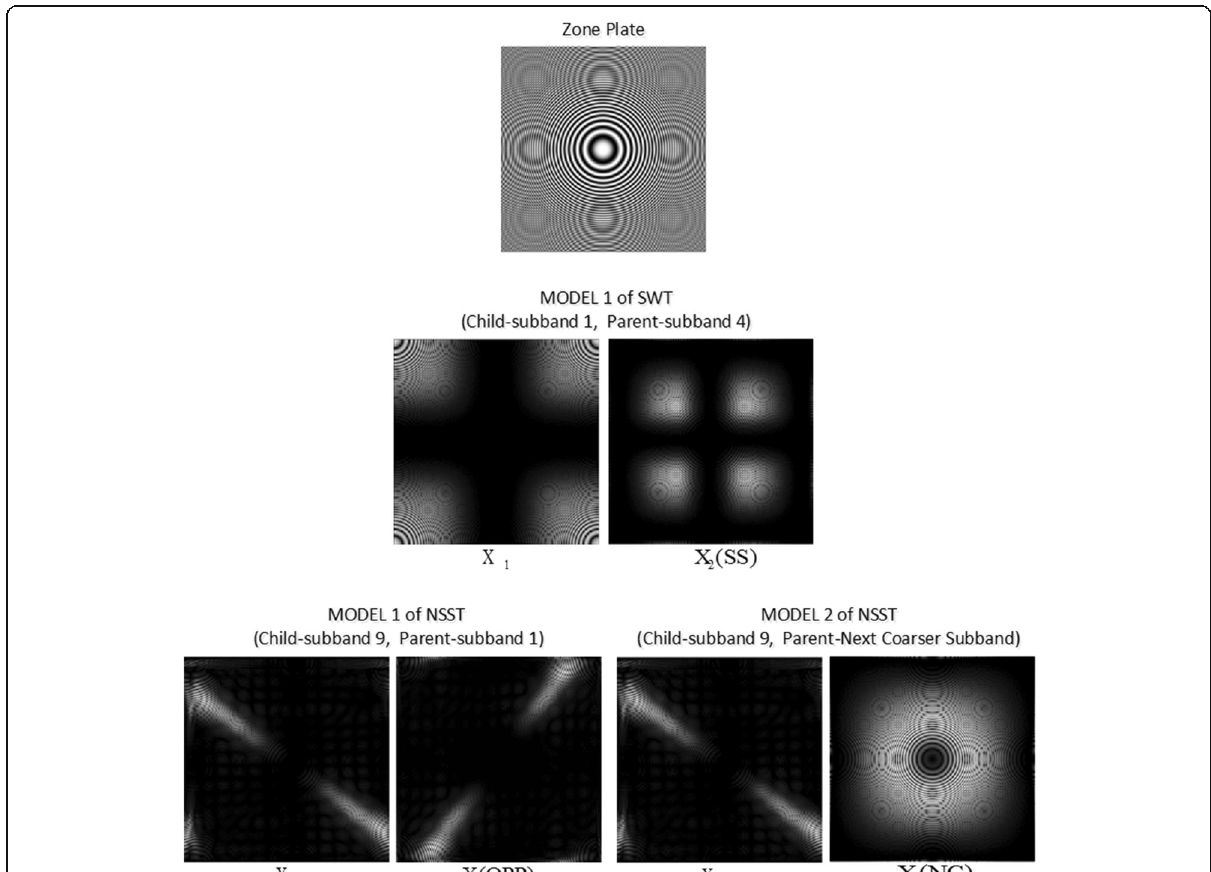
Fig. 6 Child-parent from sample image ‘ Zone Plate ’ with sizes 512 × 512 pixels in SWT and NSST domains